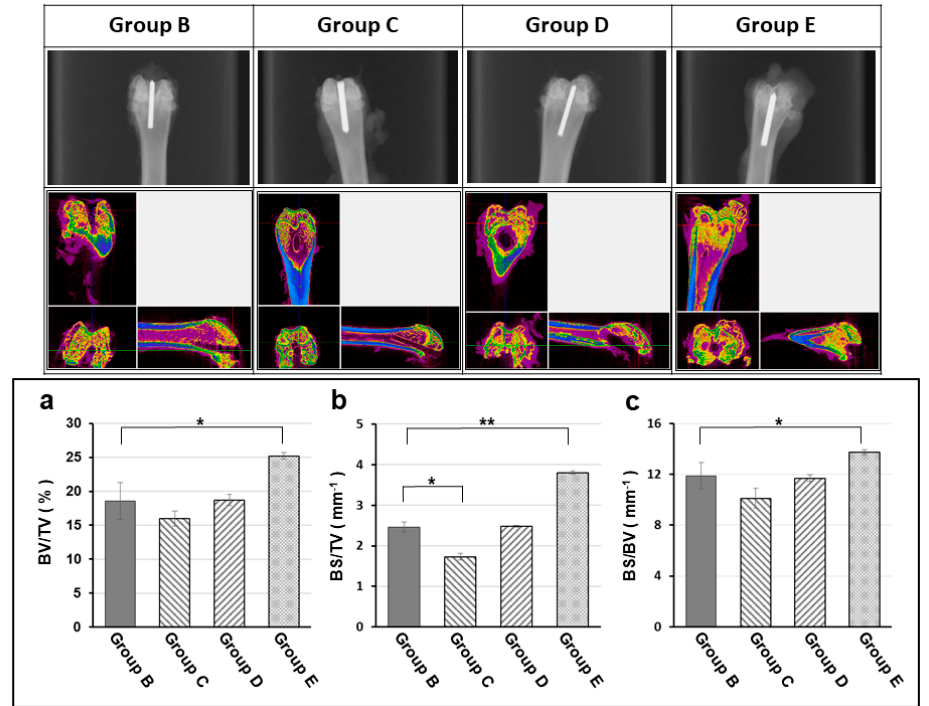
Figure 7. Radiographic, micro-CT (computed tomography) examination and bone volume change ( a : Bone volume density = BV/TV; b : Bone surface density in total volume = BS/TV; c : Bone surface density = BS/BV) at the end of experiment (12 week). The X-ray images (upper row) and micro-CT scans (middle row) showing the radiographic evaluation for degree of osteomyelitis of each experimental group at the end of experiment (12 week). The peri-implant osteomyelitis-induced bone loss is significantly lower in the TGase cross-linked gelatin/alginate/vancomycin hydrogel group. Group B: titanium implant only; Group C: titanium implant with hydrogel; Group D: titanium implant with hydrogel and Gentamicin; Group E: titanium implant with Vancomycin. All implants were loaded with 10 8 CFU/5 mL Staphylococcus aureus to promote infection. (BV: Bone Volume, TV: Total Volume, BS: Bone Surface; *: p < 0.05; **: p < 0.01)